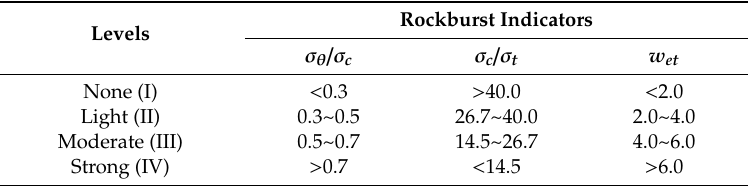
Table 2. The classification criteria of rockburst intensity.